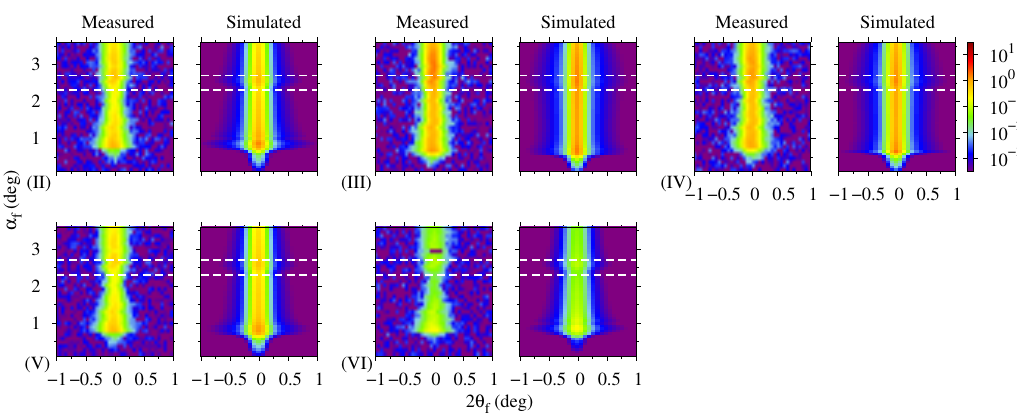
Figure 6. Polarized GISANS images of the Fe/Si multilayer ( I − + channel). (II)–(VI) correspond to the measured conditions shown in Figure